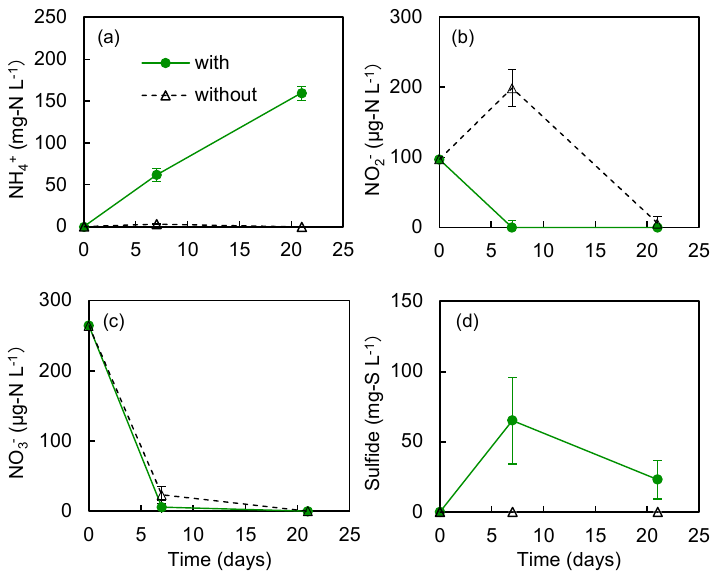
Figure 2. Changes in NH 4+ ( a ), NO 2 − ( b ), NO 3 − ( c ), and sulfide ( d ) concentrations in flasks with and without Ulva.